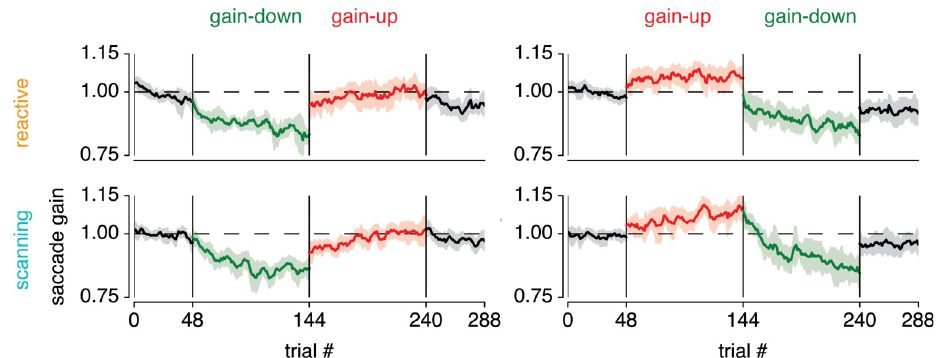
Fig 3. Saccade adaptation time-courses for the different conditions. Saccade amplitude across trials for the different saccade conditions (reactive and scanning) and for the different orders of gain direction blocks (down-up or up- down). Saccade amplitude is depicted as the ratio to median saccade amplitude in the first block (per saccade direction, see Methods) and shown as running average over 6 saccades (the hexagonal period). Shaded areas correspond to 95% CI over